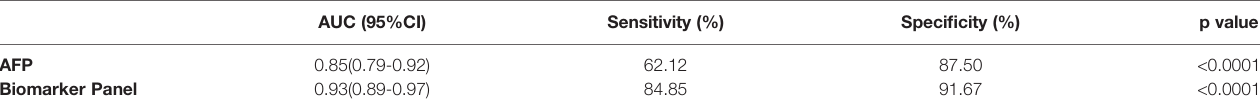
TABLE 5 | The diagnostic performance of the biomarker panel for discriminating MetS(+) HCC from MetS(+) CRC &